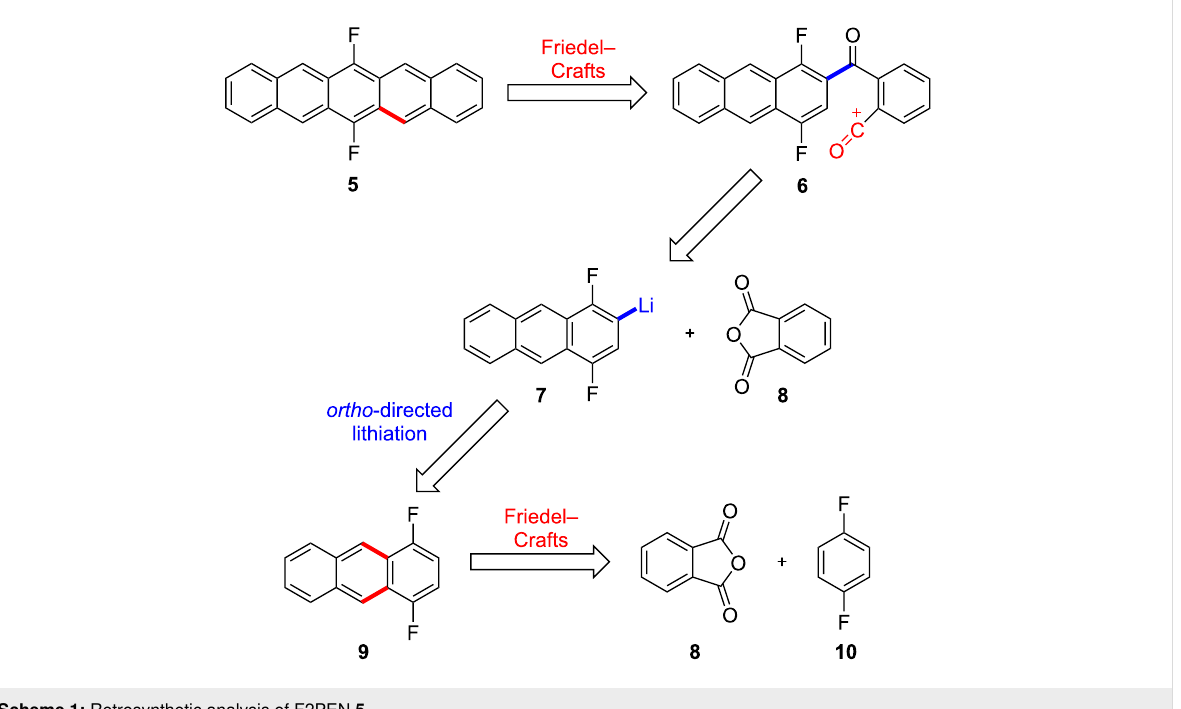
pentacenes is known to be a weak spot (because of light-in- duced dimerization or oxidation) [2] the effects of fluorination in these positions are of